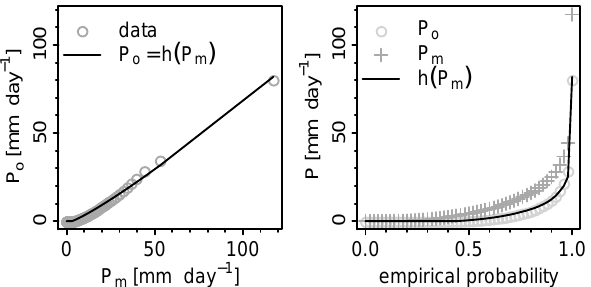
Fig. 1. Left: quantile–quantile plot of observed ( P o ) and modelled ( P m ) precipitation in Geiranger, Norway, as well as a transforma- tion ( P o = h(P m ) ) that is used to map the modelled onto observed quantiles. Right: empirical CDF of observed, modelled and trans- formed ( h(P m ) )